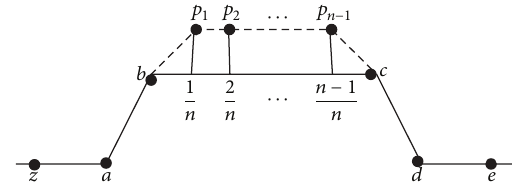
Figure 2: Labeling a sample control polygon. The newly inserted points between old vertices 𝑏 and 𝑐 are referred to as 𝑝 1 and 𝑝 2 ,